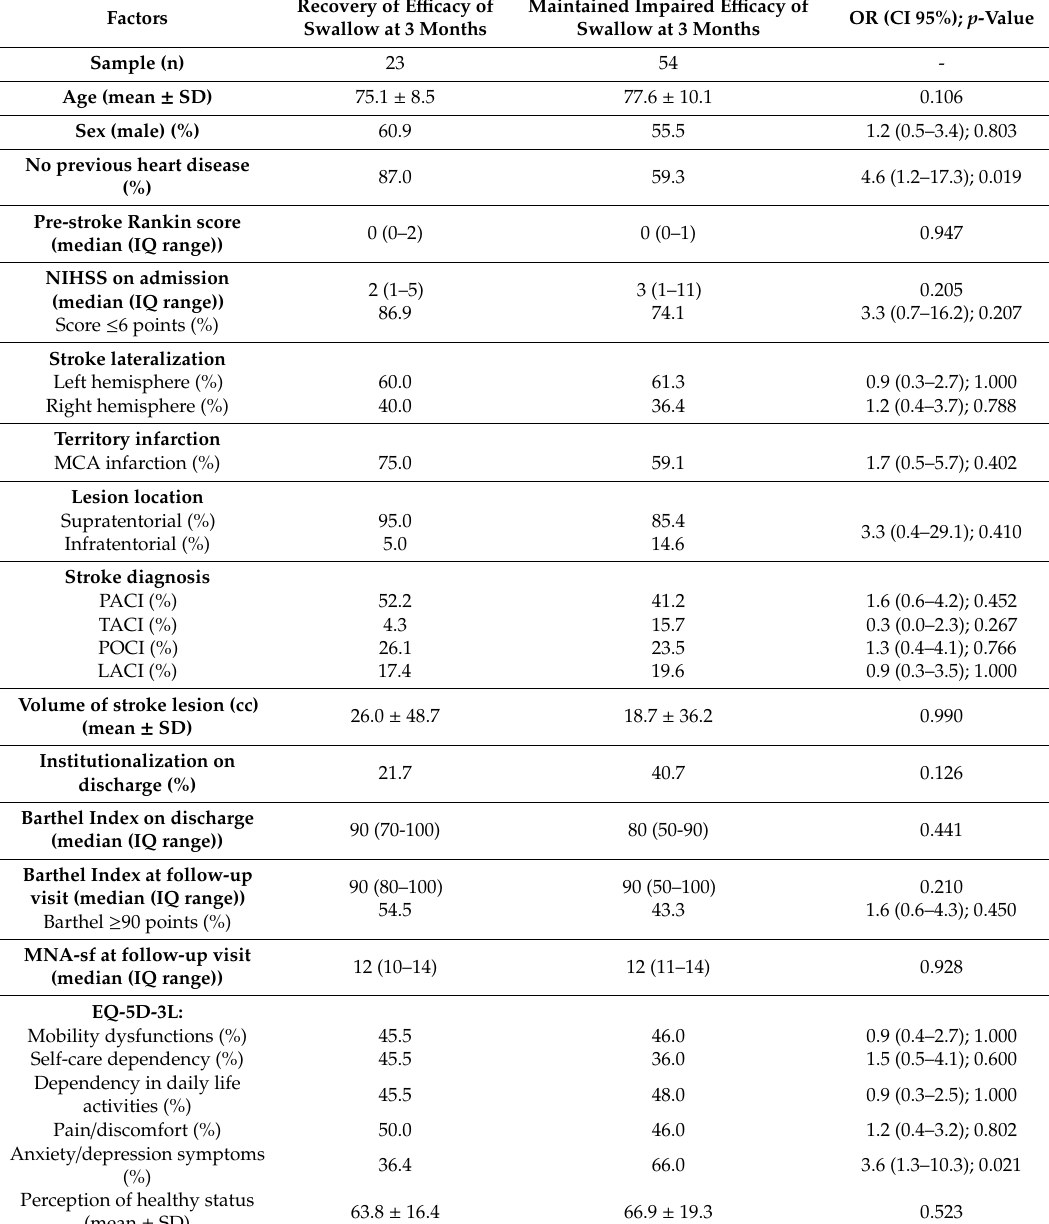
Table 3. Factors associated with recovered e ffi cacy of